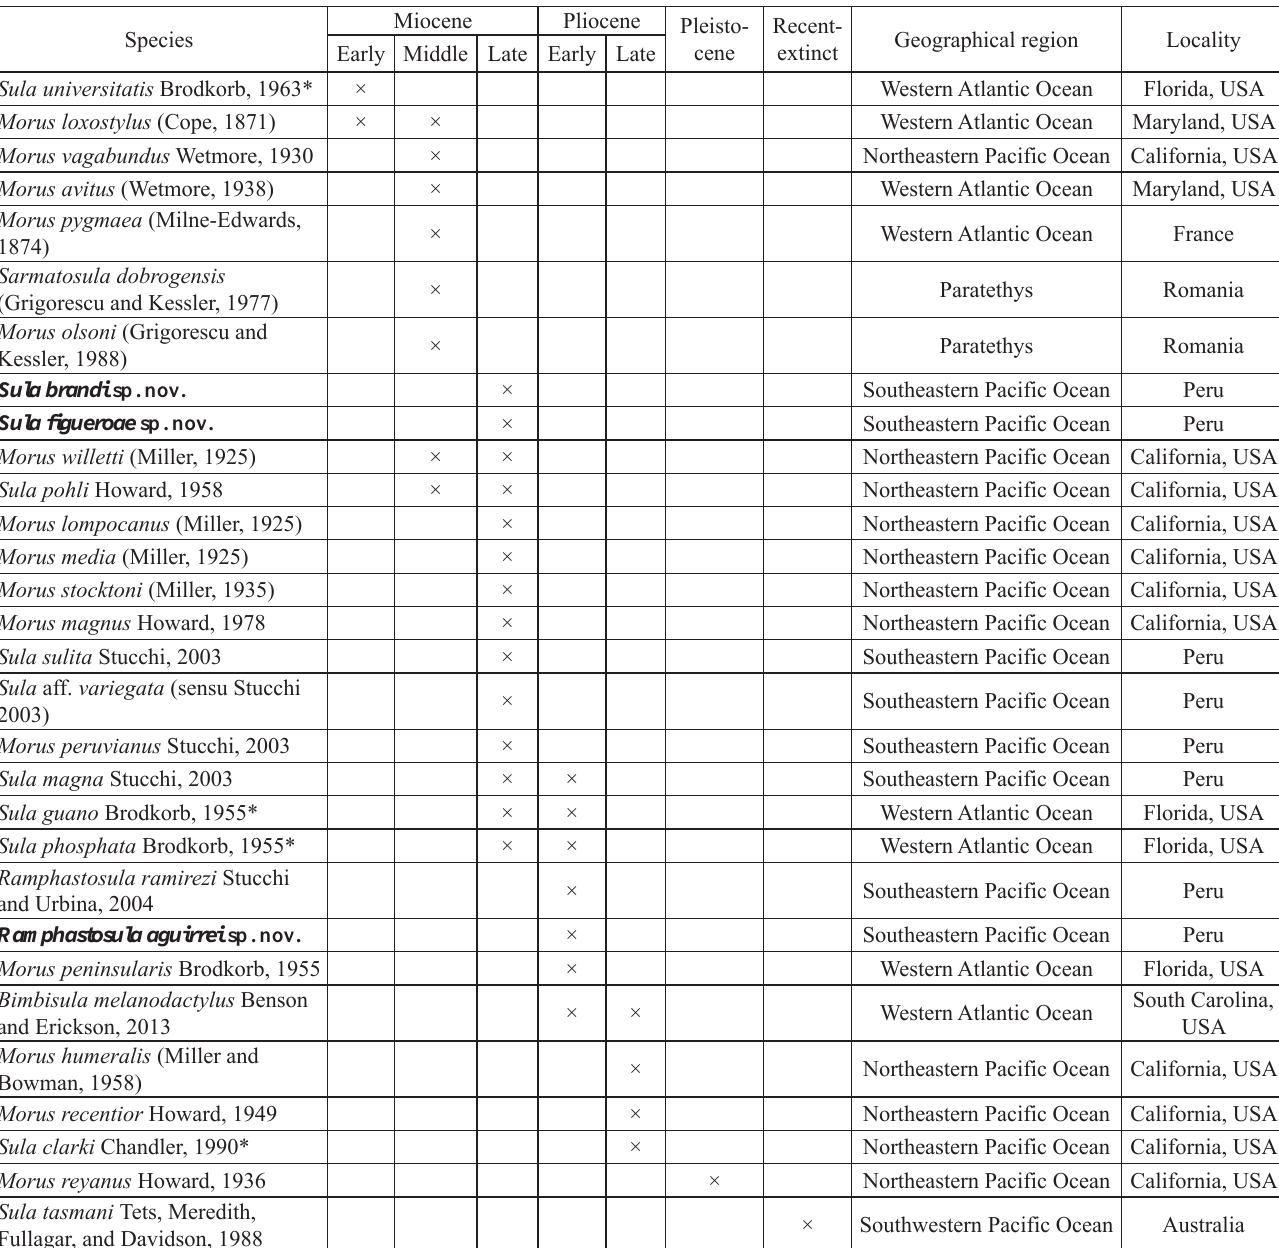
Table 1. List of the described species of the family Sulidae showing their geological age and geographical distribution. * Stucchi (2003) proposed nomina nuda for these species on the basis of classical morphometrical analysis; bold, species described in this study.